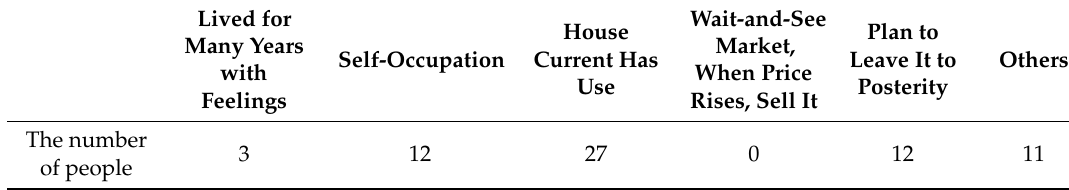
Table A4. Unwilling